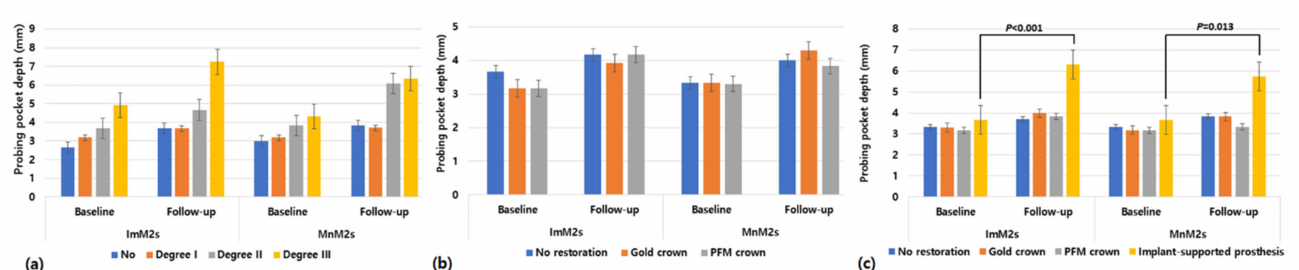
Figure 3. Changes in probing pocket depths of the mandibular first molars (MnM1s) between baseline and the last follow-up according to ( a ) furcation involvement of MnM1s, ( b ) prosthetic type of MnM1s, and ( c ) prosthetic type of antagonists. Abbreviations: ImM2s, implants placed in the mandibular second molar site; MnM2s, the mandibular second molars; PFM, porcelain fused metal crown.